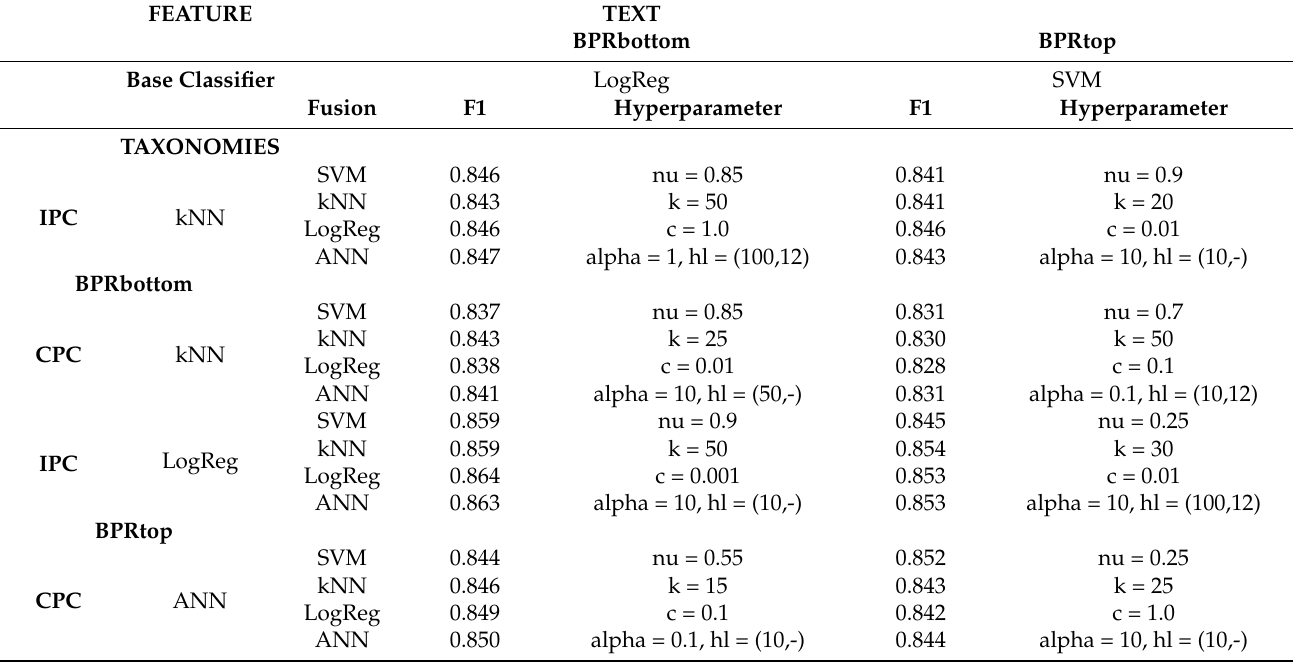
Table A2. Results of hyperparameter tuning of ensembles using stacking with four different fusion classifiers: feed-forward Artificial Neural Network (ANN), k-Nearest-Neighbor (kNN), Logistic Regression (LogReg), and Support Vector Machine (SVM). The base learners in pairs, one text and one taxonomic (either IPC or CPC) classifier, is varied according to the Base Performance Ranking (BPR: top or bottom rank). The grid search with 10-fold cross-validation (CV) was performed to maximize F1. ‘hl’ stands for